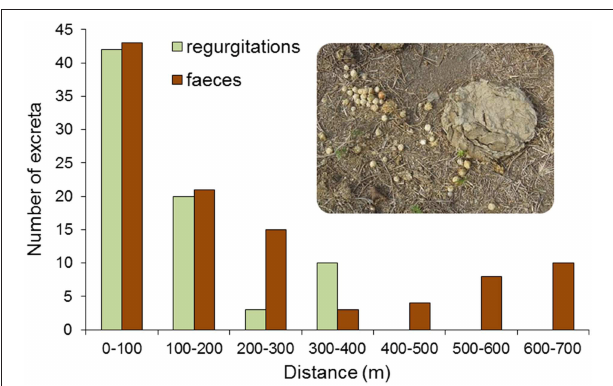
FIGURE 7 | Frequency of regurgitations containing seeds of A. totai regurgitated by cows during rumination, and frequency of cow droppings according to the distance from the border of the palm patch (two A. totai stands pooled). Both regurgitations and droppings were recorded in intensive walking surveys in the Cerrado vegetation around palm patches. The picture shows a cow regurgitation containing multiple A. totai seeds (left) close to a cow dropping without palm